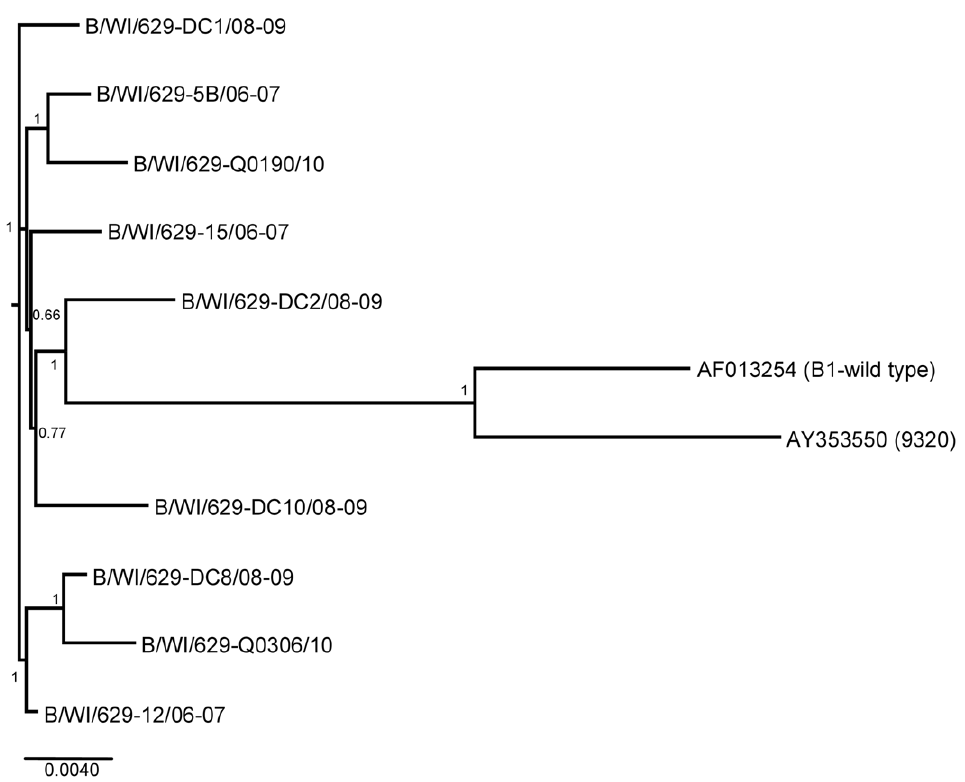
Figure 2. Phylogenetic tree of the RSV B whole genomes from Milwaukee and the two published genome sequences. The tree was calculated using 5 6 10 6 generations in MrBayes and a burn in of 15. Node values are posterior probabilities. (In parenthesis are the published strain names).